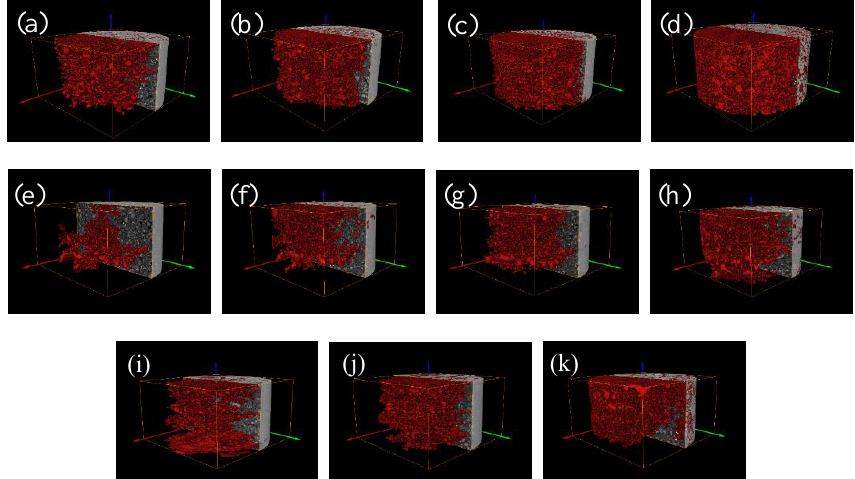
Figure 11. Connected pore structure under three levels of the water content at the three levels of fine particle content. ( a ) First-level head of 30% fine content; ( b ) Second-level head of 30% fine content; ( c ) Third-level head of 30% fine content; ( d ) Fourth-level head of 30% fine content; ( e ) First-level head of 50% fine content; ( f ) Second-level head of 50% fine content; ( g ) Third-level head of 50% fine content; ( h ) Fourth-level head of 50% fine content; ( i ) Second-level head of 70% fine content; ( j ) Third-level head of 70% fine content; ( k ) Fourth-level head of 70% fine content.